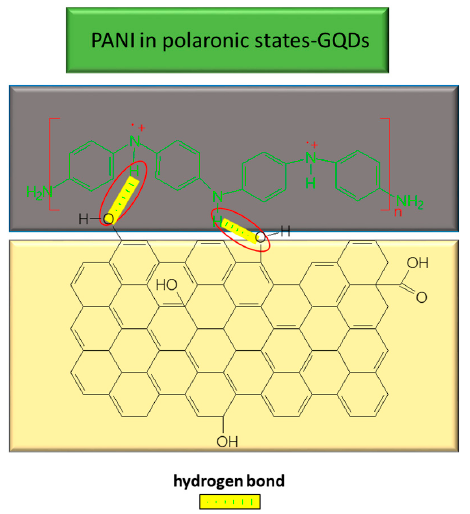
Figure 12. Interaction between GQDs and PANI in composite used for UA detection. UA detection has been carried out using GCE covered by drop casting with an SnO 2 /PANI/N–GQD composite. According to [116], DPV studies indicated that the SnO 2 /PANI/N–GQD/GCE sensorial platform shows three oxidation maxima in the pres- ence of DA, AA, and UA, with potentials at +0.096 V, − 0.192 V, and 0.287 V, respectively [116]. The LR of the SnO 2 /PANI/N–GQD/GCE sensorial platform, in the case of DA mixed with AA and UA, is between 5 × 10 − 7 M and 2 × 10 − 4 M [116]. In the experiment conducted by Lim, H.C. et al., GCE modified with PEDOT/GQDs detected AA, DA, and UA in the presence of PBS at a pH of 7.4. Three anodic peaks were observed for the three analytes UA, DA, and AA at 0.311 V, 0.180 V, and 0.055 V [117]. The LR of this sensor was reported to be between 30–1000 μ M [117]. For the four sensorial platforms, one can observe that the LOD varied between 2.2 × 10 − 7 M and 10 − 9 M (see Table 4). These values were explained by considering the high surface area of GQDs and higher weight of active sites on the GQDs surface. Another explanation concerning GQDs-based high speed induced by the edge effect, and to the quantum confinement of GQDs. A study